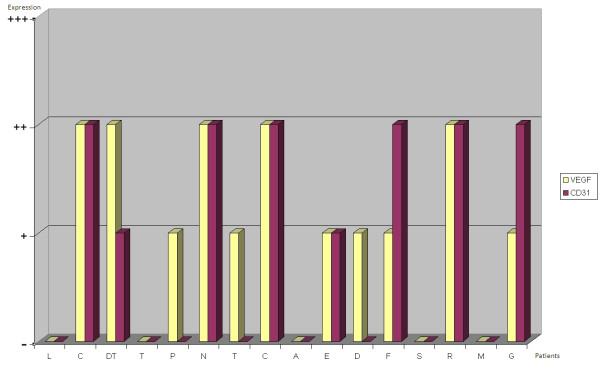
Bar charts showing levels of VEGF and CD31 expression in pre-chemotherapy biopsy specimens.